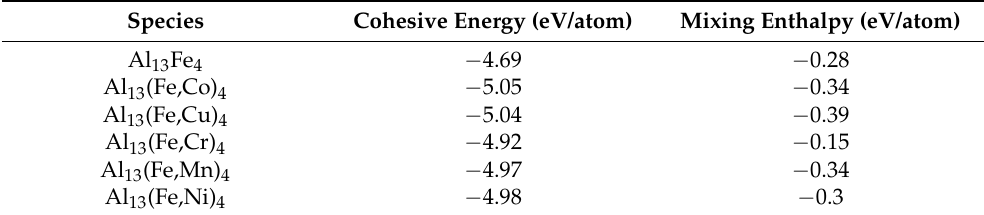
Table 3. The calculated mixing enthalpy and cohesive energy (eV/atom) of Al 13 (Fe,M) 4 phases with Co, Cu, Cr, Mn, and Ni